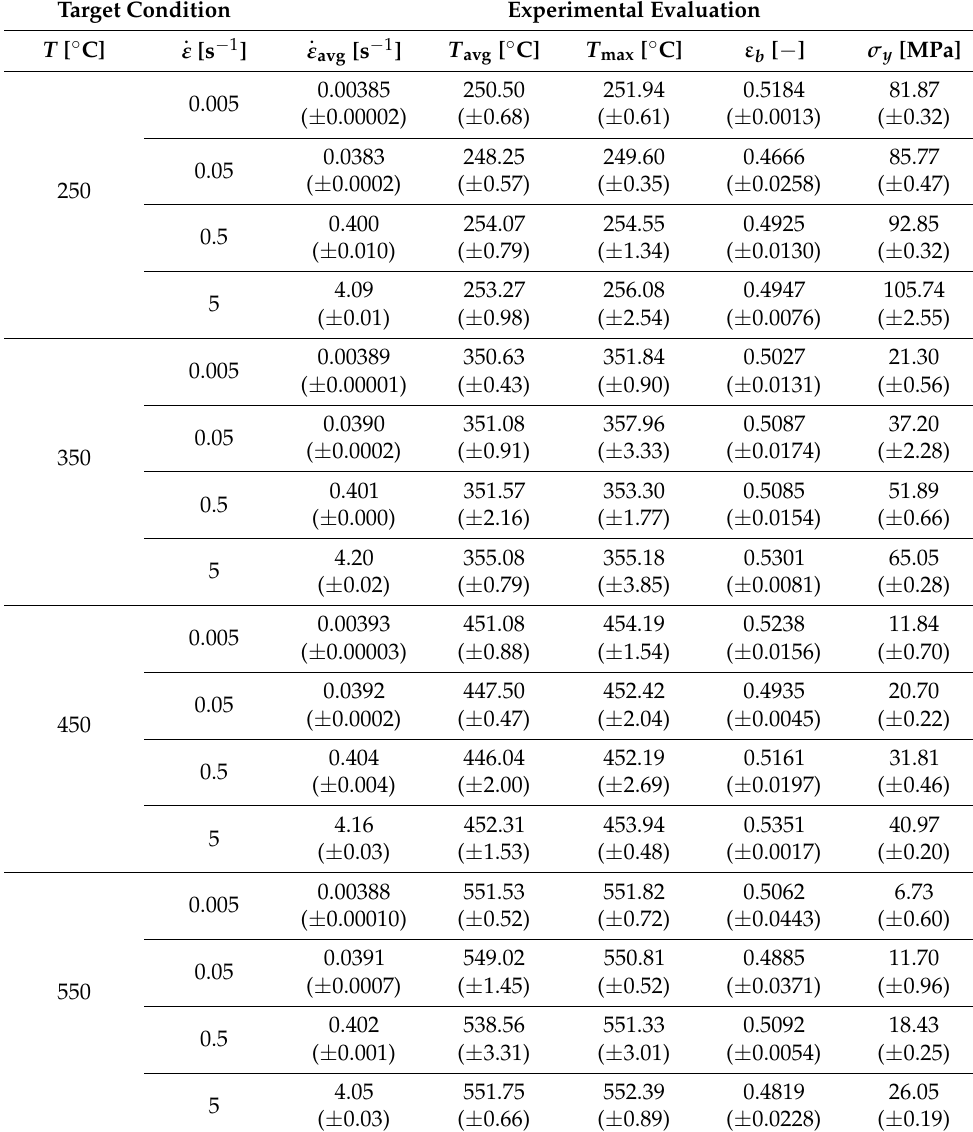
Table 1. Evaluation of the physical quantities at each target condition of the compression tests. Target